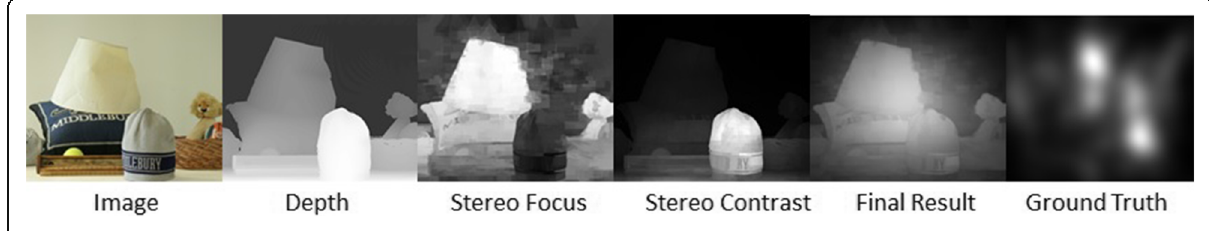
Fig. 8 An example of the proposed visual saliency